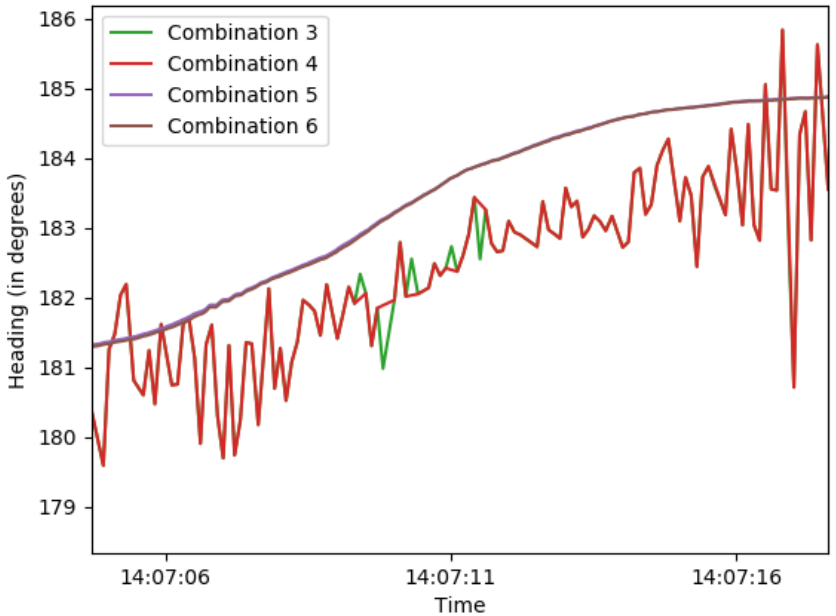
Figure 8. Heading values of a portion of the data in combinations with (5 and 6) and without (3 and 4) Kalman filter